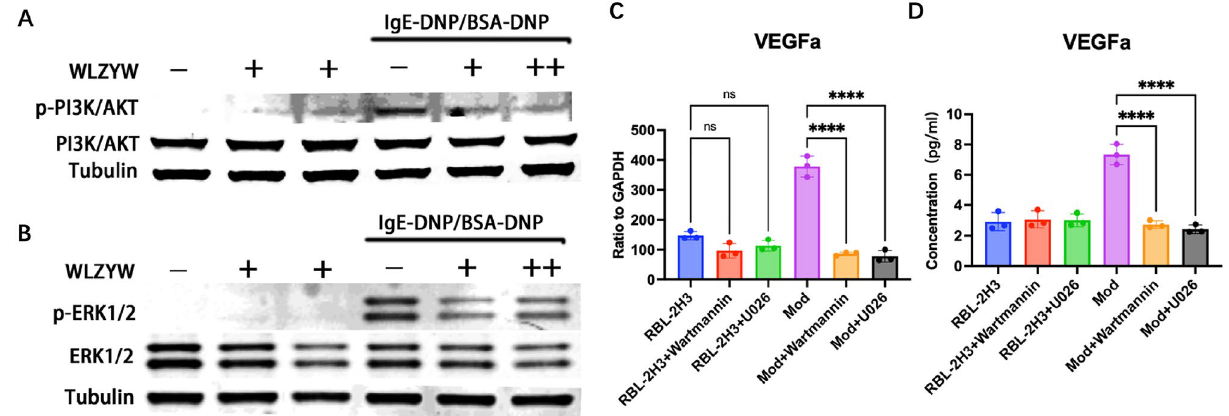
Figure 6. Effects of WLZYW on VEGFa and signaling pathways. WLZYW (50 μg/mL) inhibited the phosphorylation levels of p-PI3K/AKT ( A ) and p-ERK1/2 ( B ) in DNP-IgE/BSA induced degranulation model. After RBL-2H3 degranulation was inhibited by Wortmannin (1 μM) and U0126 (2 μM), VEGFa mRNA ( C ) and protein ( D ) levels were significantly downregulated. Values represent mean ± SD from three independent experiments, ****p < 0.0001, ns means no significant